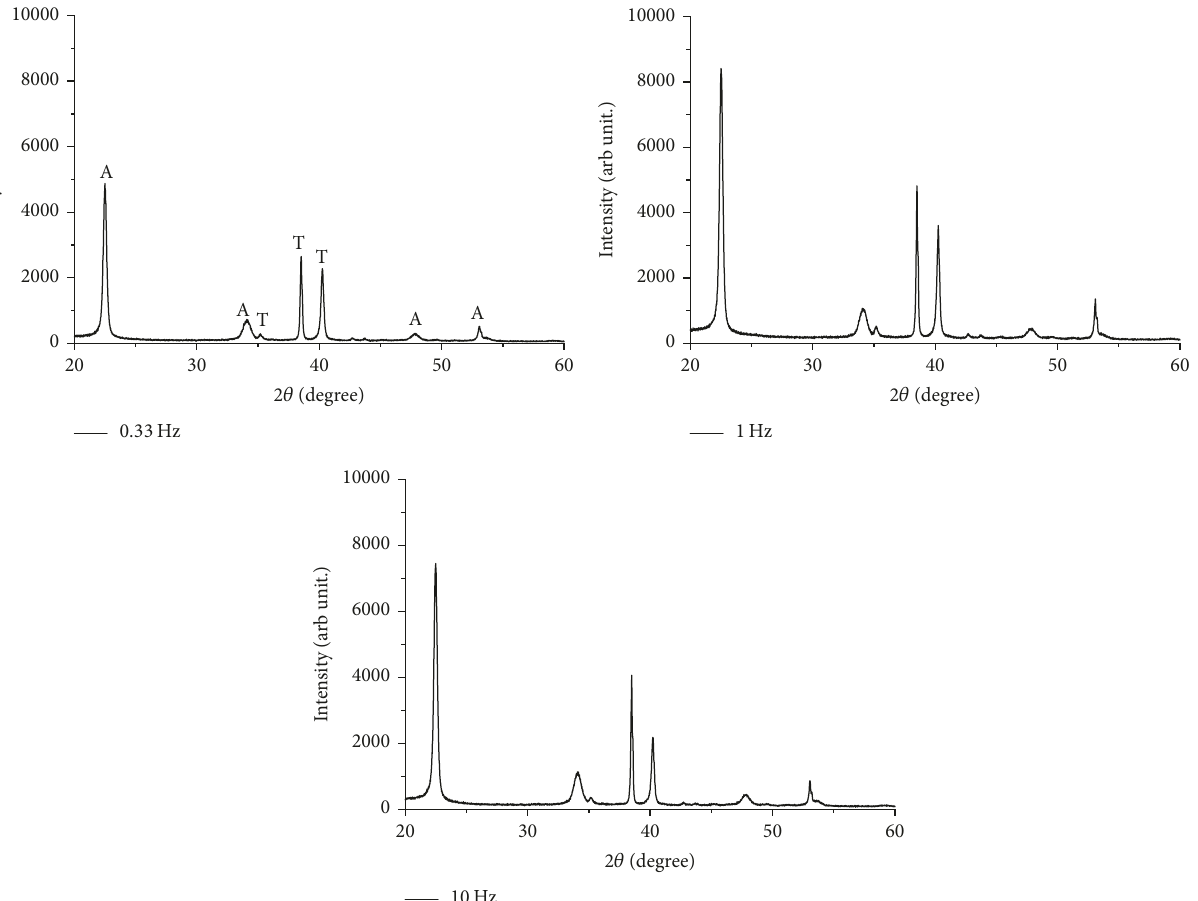
Figure 3: XRD spectra of nonelectropolished titanium surfaces after anodisation at different pulsed current frequencies (A: anatase, T: titanium).